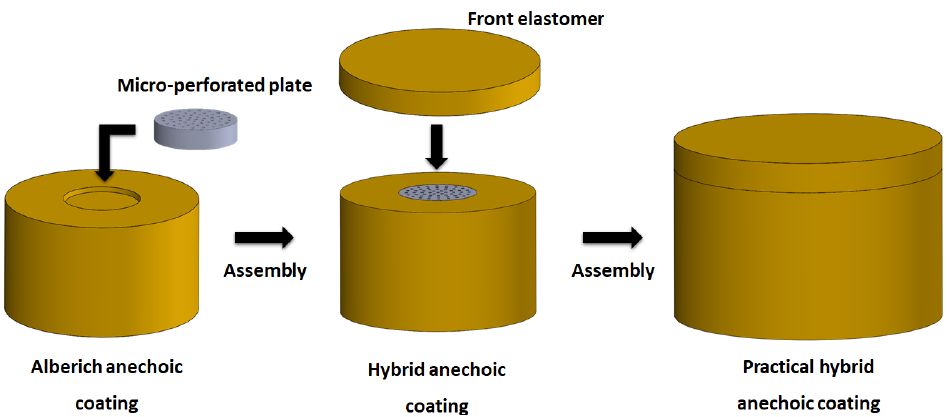
Figure 21. The practical applications of metastructure assembly process.